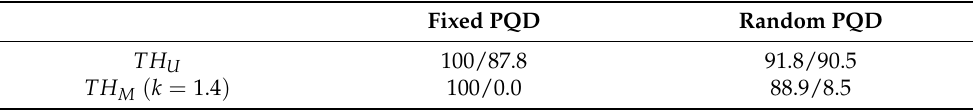
Table 3. Comparison of PQD metrics.